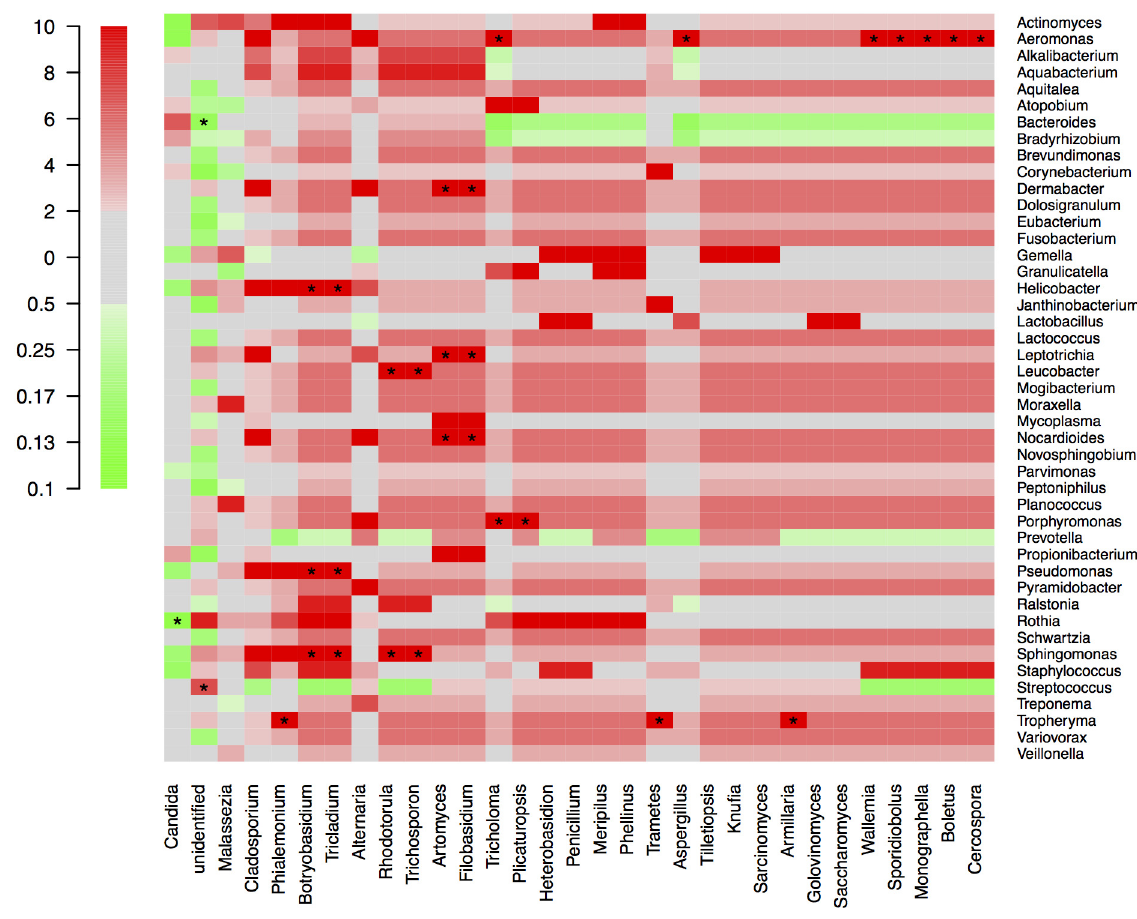
Fig 9. Associations/dissociations between bacteria and fungi (heatmaps). Relationships (association/dissociation) between bacteria and fungi in lower respiratory tract samples of non-neutropenic intubated and mechanically ventilated ICU patients with antibiotic therapy due to pneumonia calculated as odds ratios and depicted as heatmap. An odds ratio above 2 was considered a positive association (in red), an odds ratio below 0.5 was interpreted as negative association (= dissociation, in green). The scale shows odds ratios. Asterisks show significant differences (p < 0.05; 95% confidence interval) for odds ratios (Fig